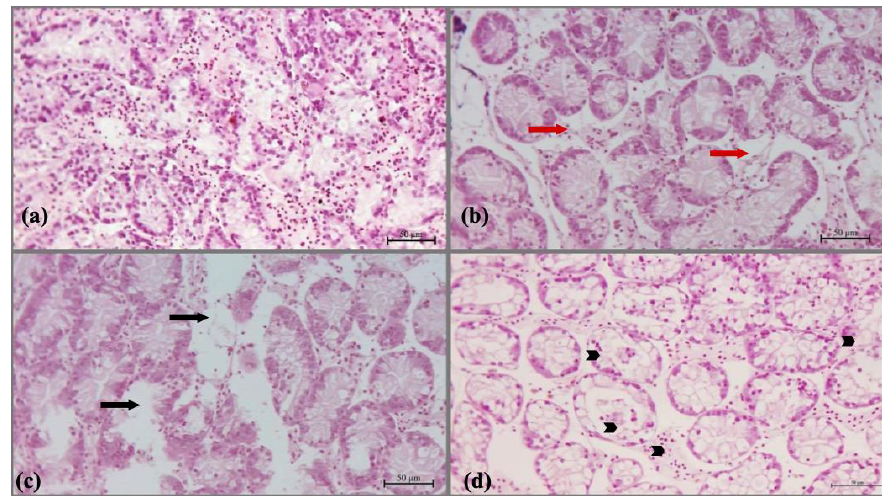
Figure 7. Digestive gland tissue of the freshwater mussel, Unio delicatus ( a ) control, ( b ) deformation of the tubules (red arrows) after exposure to 0.264 mg/L fipronil for 48-h, ( c ) necrosis of the digestive tubules (black arrows) after exposure to 0.528 mg/L fipronil for 7-d ( d ) deformation of the tubules after exposure to 0.524 mg/L fipronil for 7-d (black arrow heads) (H&E).